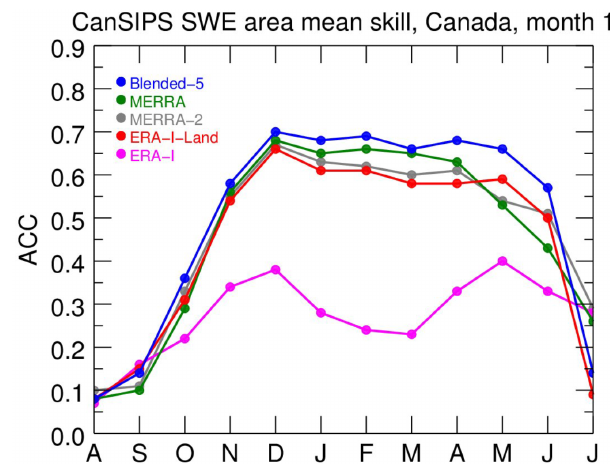
Figure 13. Anomaly correlation coefficient (ACC) averaged over Canada for first-month CanSIPS forecasts of SWE, verified against several observation-based datasets including Blended-5 (blue), MERRA (green), MERRA-2 (grey), ERA-Interim Land (red), and ERA-Interim (magenta); the MERRA and ERA-Interim Land are components of Blended-5. Blended-5 shows the best agreement with the forecast, suggesting a strong influence of observational dataset on evaluation of forecast